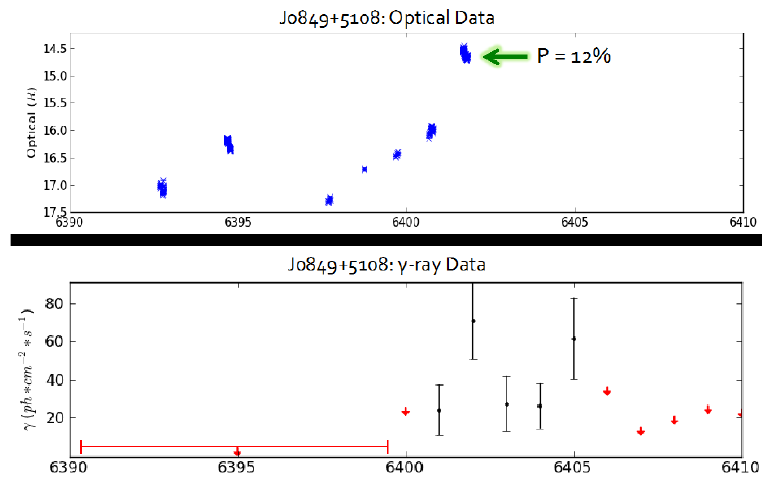
Figure 4. Rapid, large-amplitude gamma-ray and optical variations for J0849+5108.